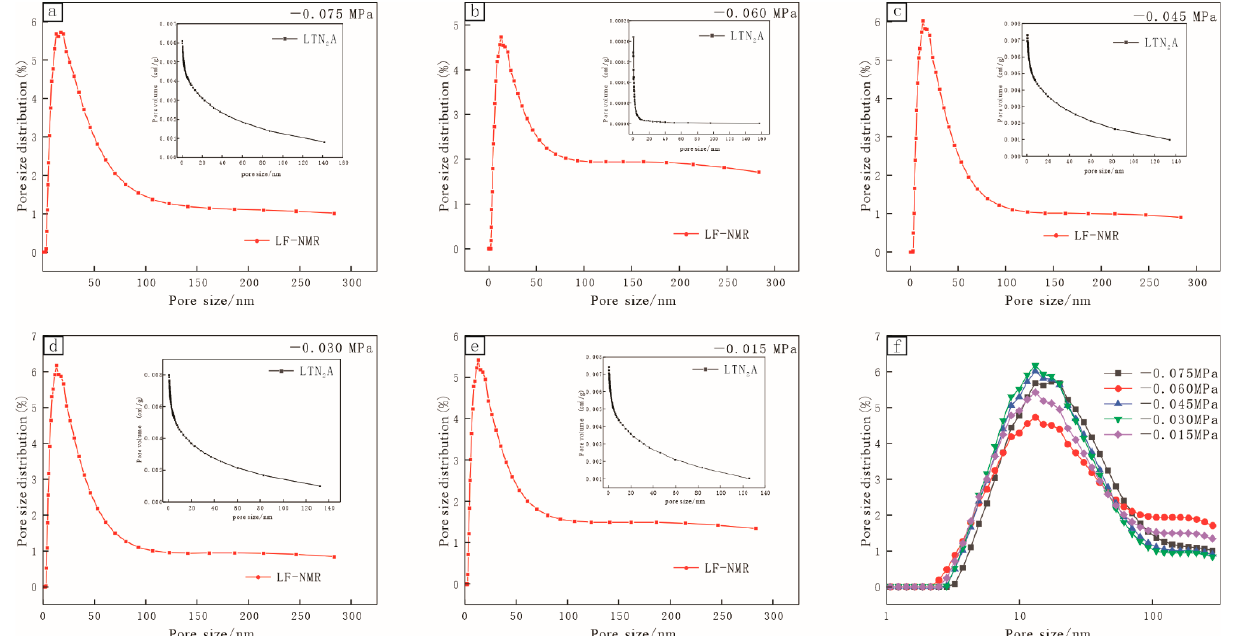
Figure 8. ( a – f ) Comparison of pore size distribution between NMR conversion and LT-N 2 A.